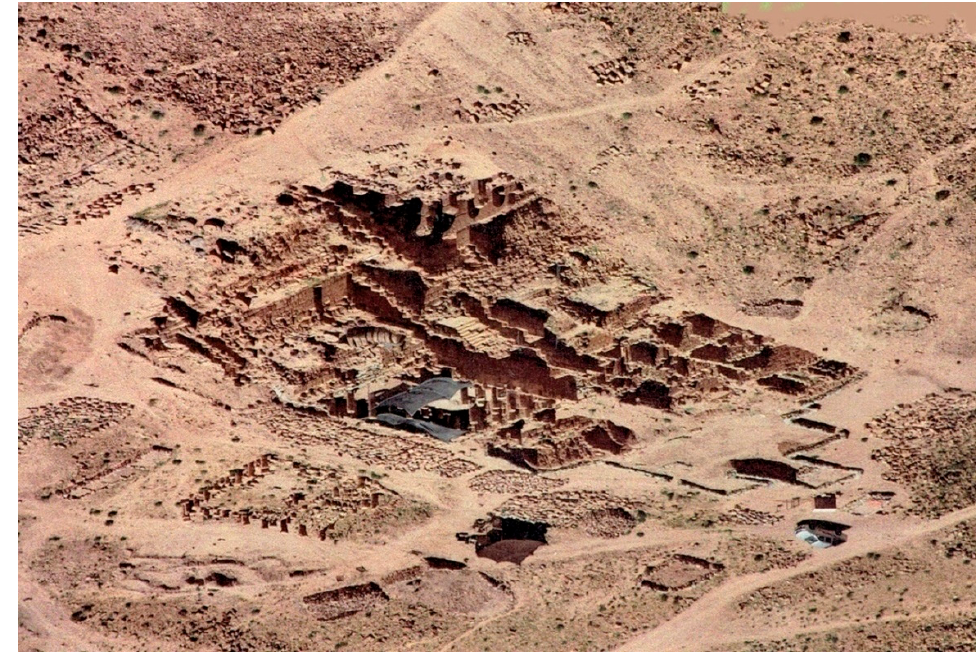
Figure 9. Temple of the Winged Lions [4].